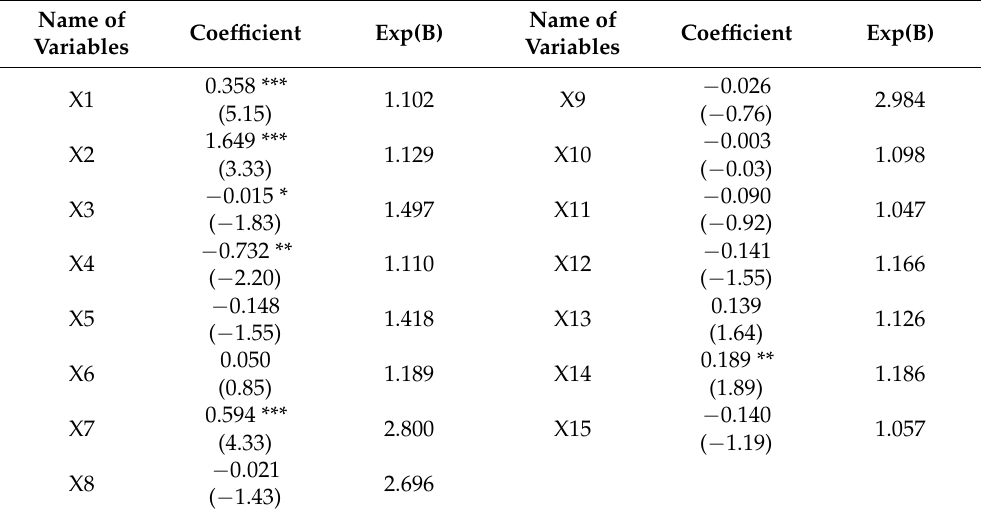
Table 3. Summary of model fitting